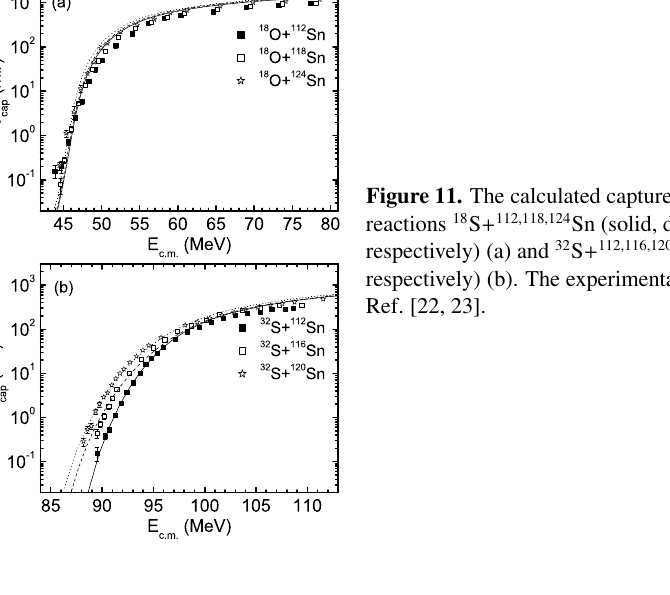
Figure 11. The calculated capture cross sections vs E c . m . for the reactions 18 S + 112 , 118 , 124 Sn (solid, dashed and dotted lines, respectively) (a) and 32 S + 112 , 116 , 120 Sn (solid, dashed and dotted lines, respectively) (b). The experimental data (symbols) are from Ref. [22,